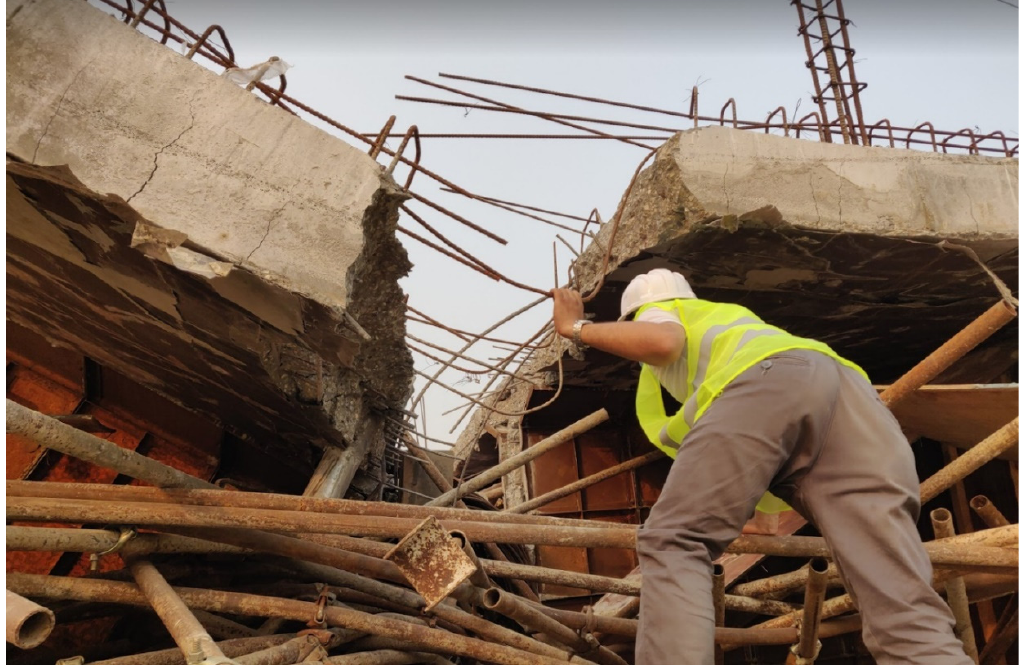
Figure 9. Fracture observed in slab of Span-2, including several flexural cracks near both sides of the main fracture region.